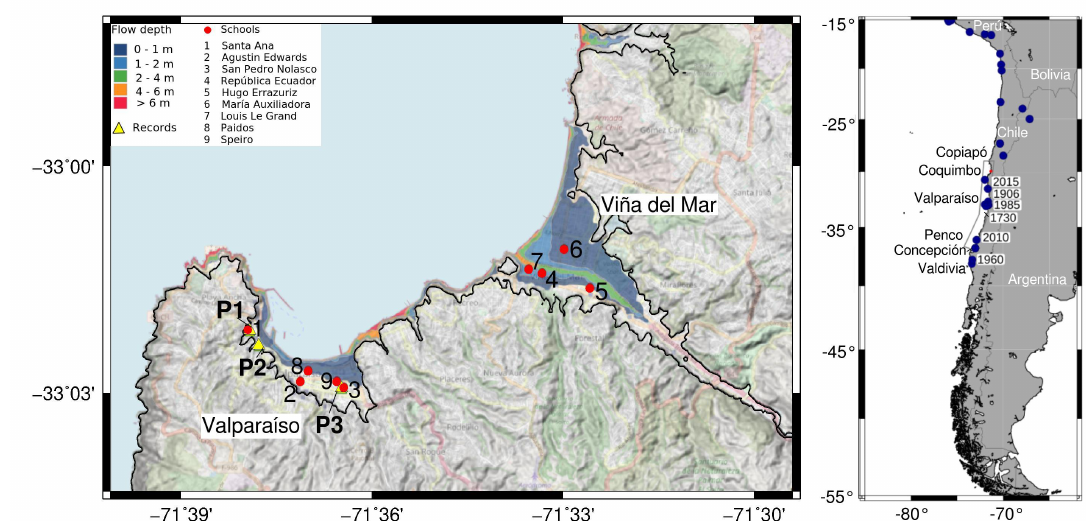
Figure 1. Left panel: Map showing the extent of maximum tsunami inundation according to the Tsunami Inundation Chart for Valparaíso and Viña del Mar [3]. Yellow triangles show the data of the tsunami inundation extent based on historical records along Valparaíso. P1 stands for the location of La Matriz church where historical records indicated the maximum wave height of 9 m. P2 stands for the location of the Augustinian convent where historical records reported the maximum wave height of 11 m. P3 stands for Mercedarian convent where the maximum wave height reported in historical records was 9 m [1,4]. The contour line of 30 m above sea level (m.a.s.l.) is shown in black. The numbers refer to the schools where talks were given. The right panel shows the location of selected coastal cities in Chile. Blue circles stand for approximated earthquake epicenters greater than Mw 8.0 in the year 1500–2020 (the year of occurrence is given for selected events). The earthquake locations are based on ComCat